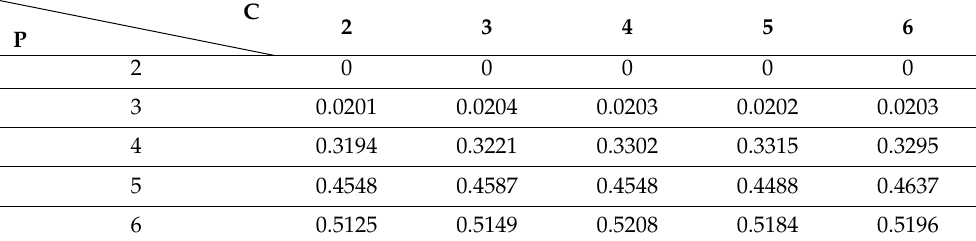
Table 3. Prediction performance CGK-based fuzzy granular model of the aggregated structure that generated contexts uniformly.